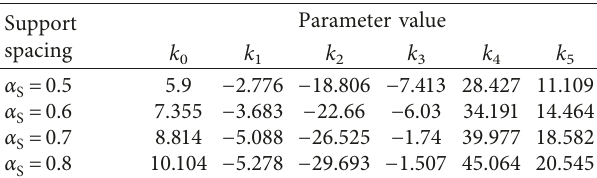
Figure 7: Fitting curves of the dimensionless crack width and the dimensionless stress intensity factor. (a) α � 0.8. and (d) α S Table 3: Value of parameters in formula